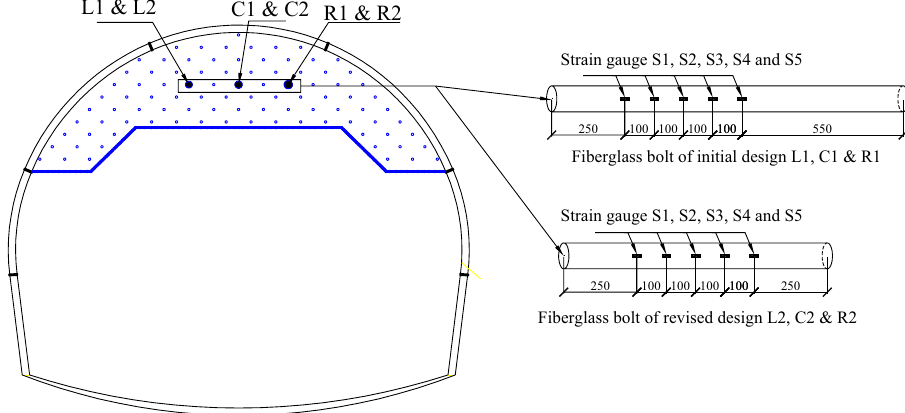
Figure 14. Location of the tested bolts in the excavation face and the strain gauge positions on the bolts.